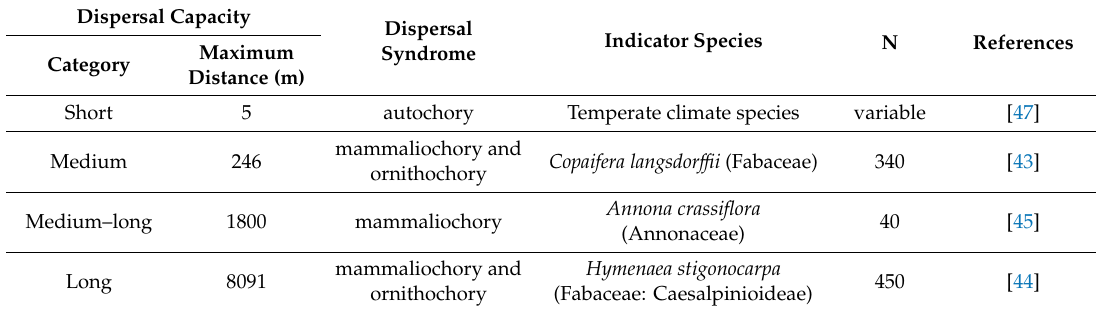
Table 2. Dispersal distance profiles of plant species used as indicators of dispersal capacity in the Cerrado. N = number of individuals